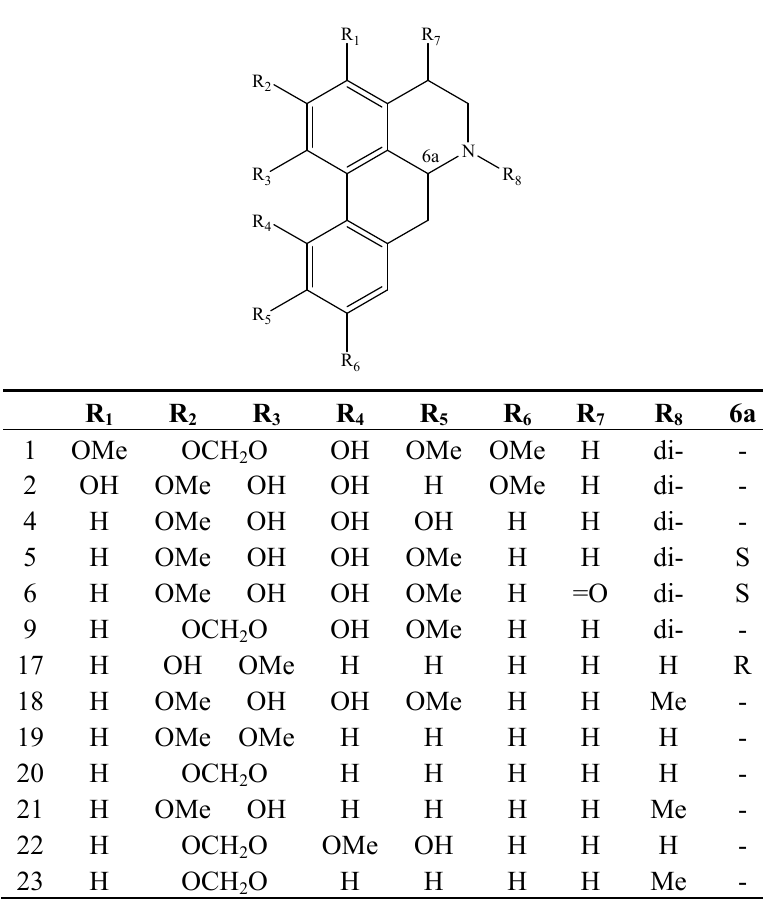
Figure 1. Structures of compounds 1 – 23